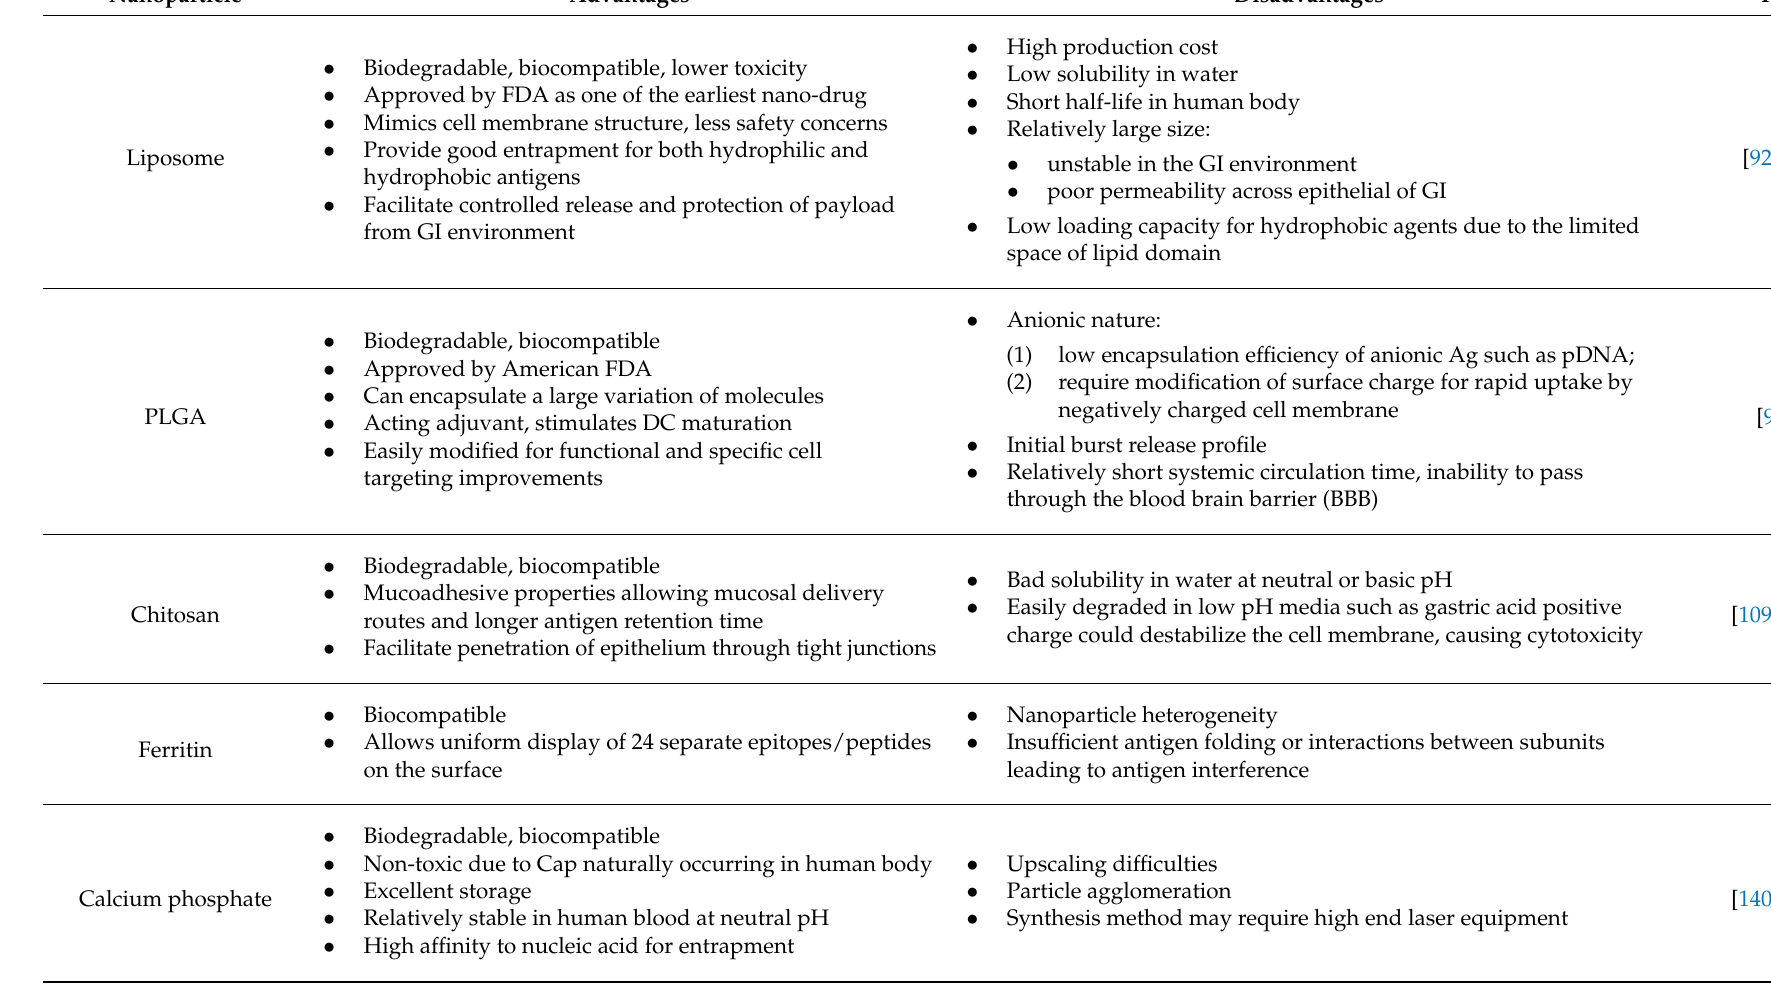
Table 2. Advantages and disadvantages of various nanoparticles. Nanoparticle